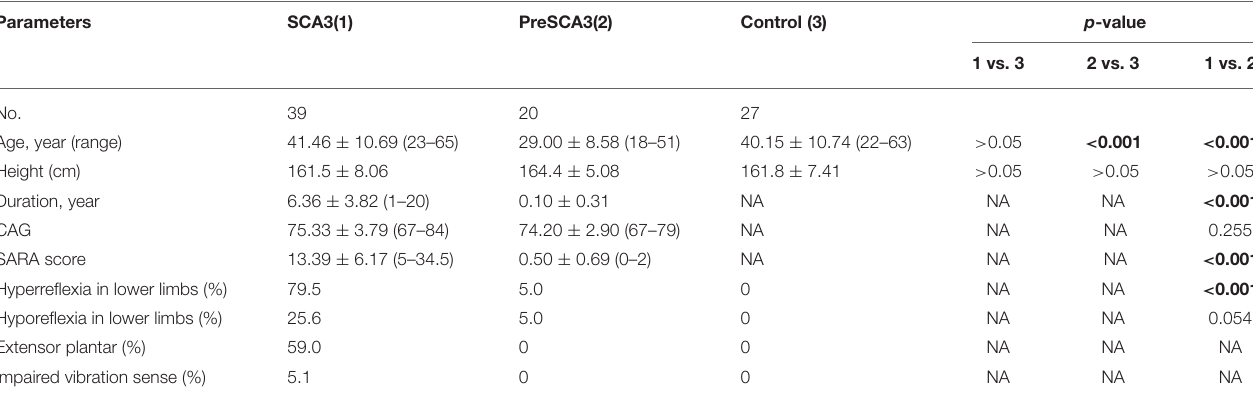
TABLE 1 | Clinical profiles of the participants in the